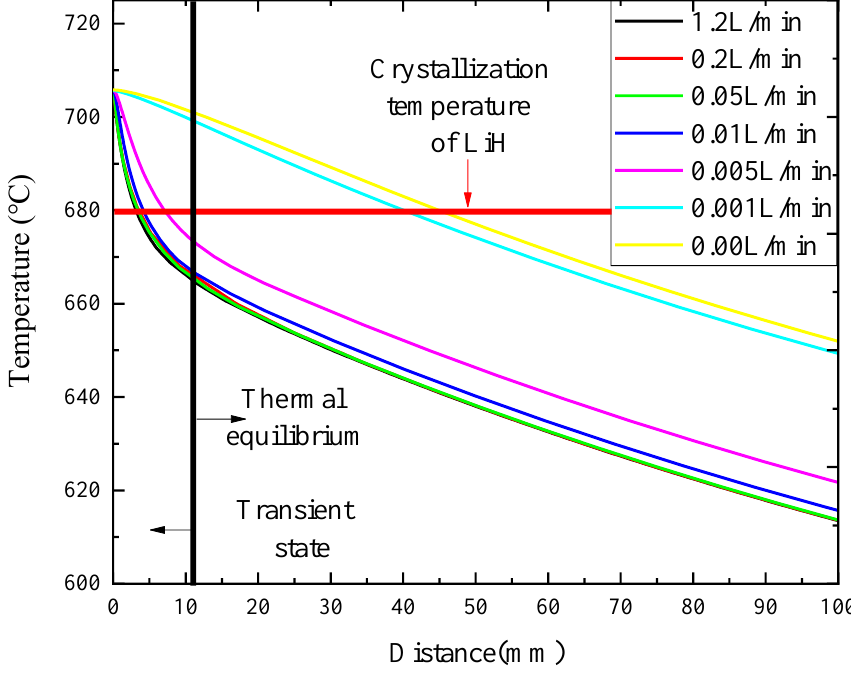
Figure 11. The temperature variation of the LiH conical point at different flow flux.